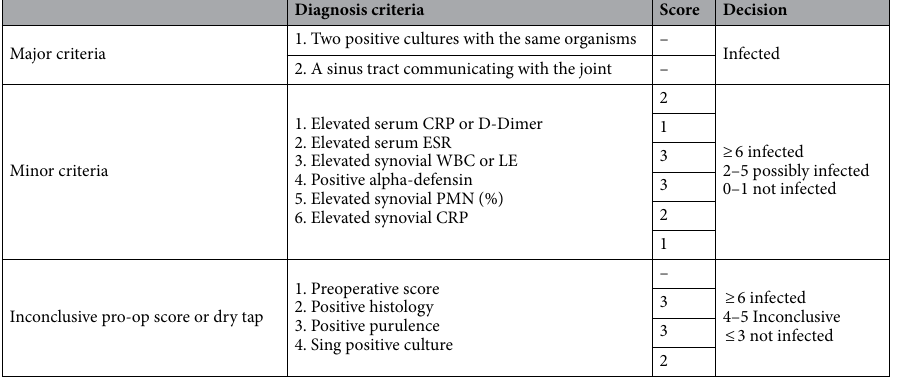
Table 1. The evidence-based definition for periprosthetic joint infection (PJI).